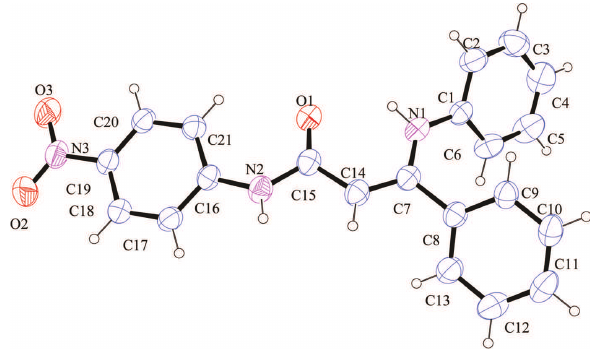
Table 1: Data collection and